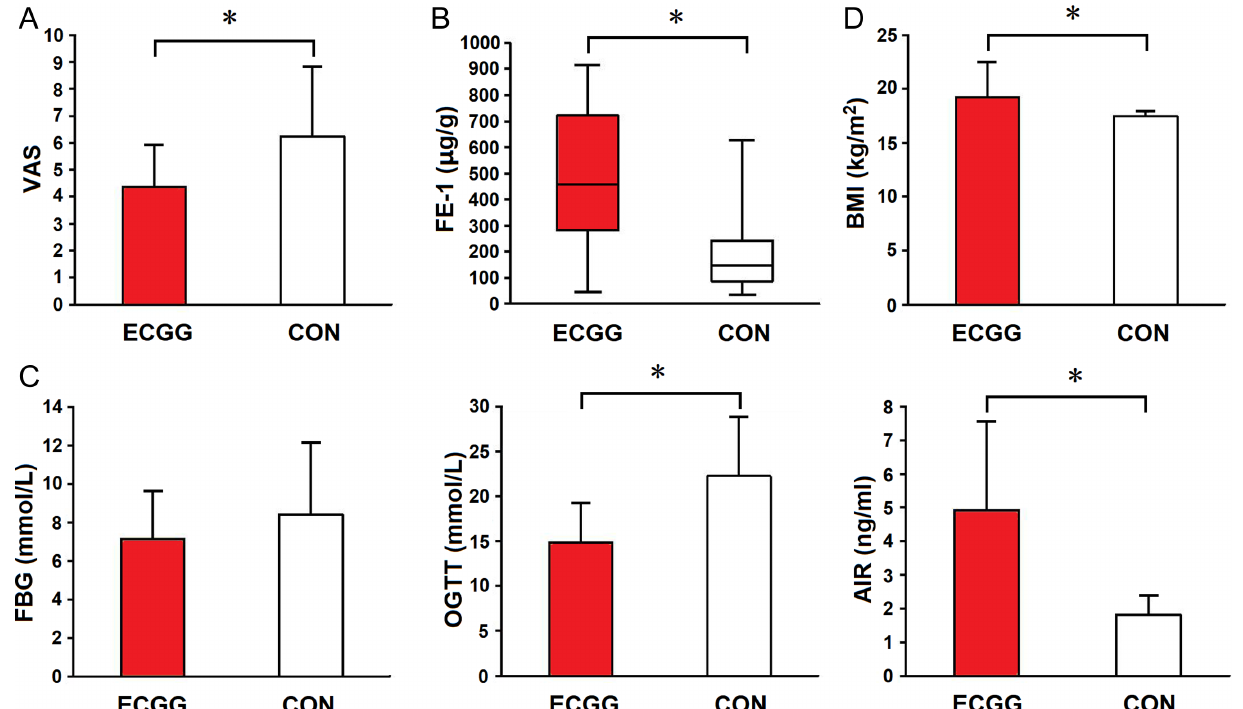
Figure 2. Endothelium corneum gigeriae galli relieved abdominal pain and improved exocrine and endocrine pancreatic function and nutritional status. (A) Abdominal pain detected by VAS. Data were shown as the mean ± SD of both groups; * P < .05, Student’s t -test. (B) Exocrine pancreatic function was determined by FE-1. Data were shown as the median ± QR of both groups; * P < .05, Kruskal–Wallis test. (C) Endocrine pancreatic function was evaluated by FBG, OGTT, and AIR. Data were shown as the mean ± SD of both groups. * P < .05, Student’s t -test. (D) Nutritional status was detected by BMI. Data were shown as the mean ± SD of both groups; * P < .05, Student’s t -test. CON, group control; VAS, visual analog scale; SD, standard deviation; FE-1, fecal elastase-1; FBG, fasting blood glucose; OGTT, oral glucose tolerance test; ECGG, endothelium corneum gigeriae galli; QA, quartile